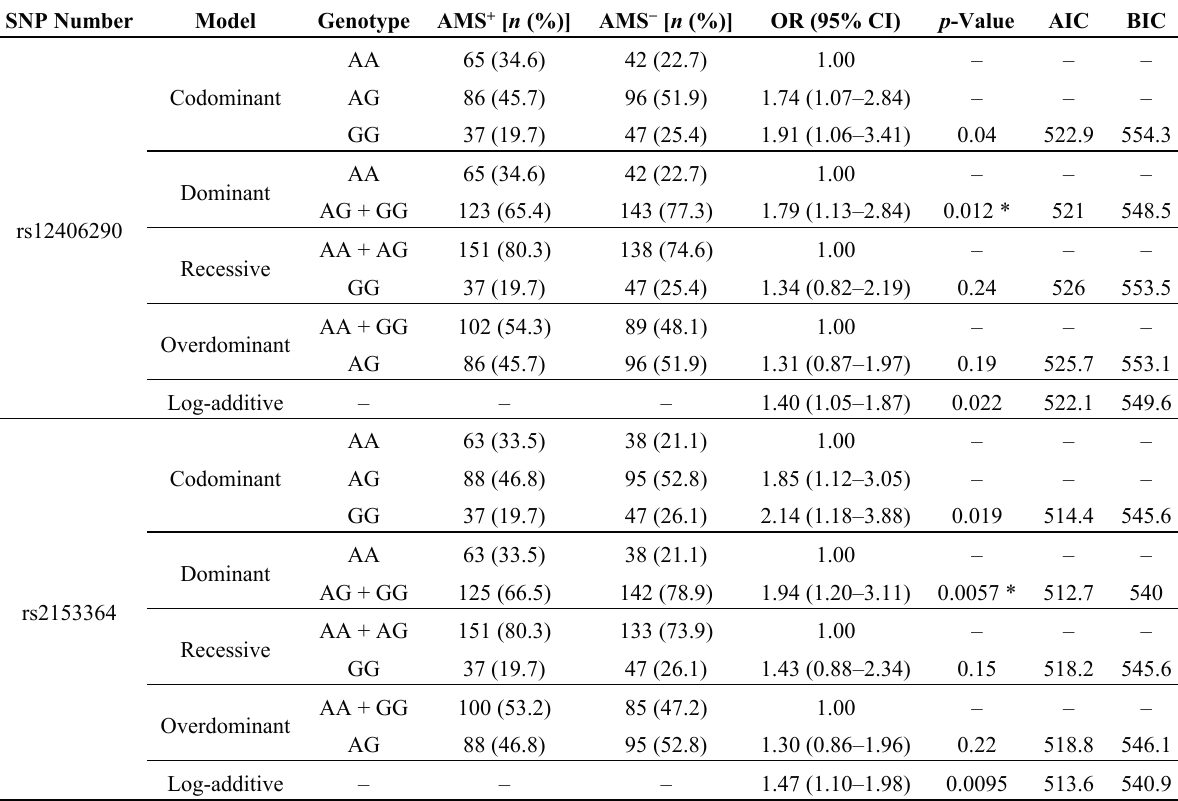
Table 3. Single nucleotide polymorphism genetic models and analyses of the association between SNPs and acute mountain sickness (AMS) adjusted for age and smoking